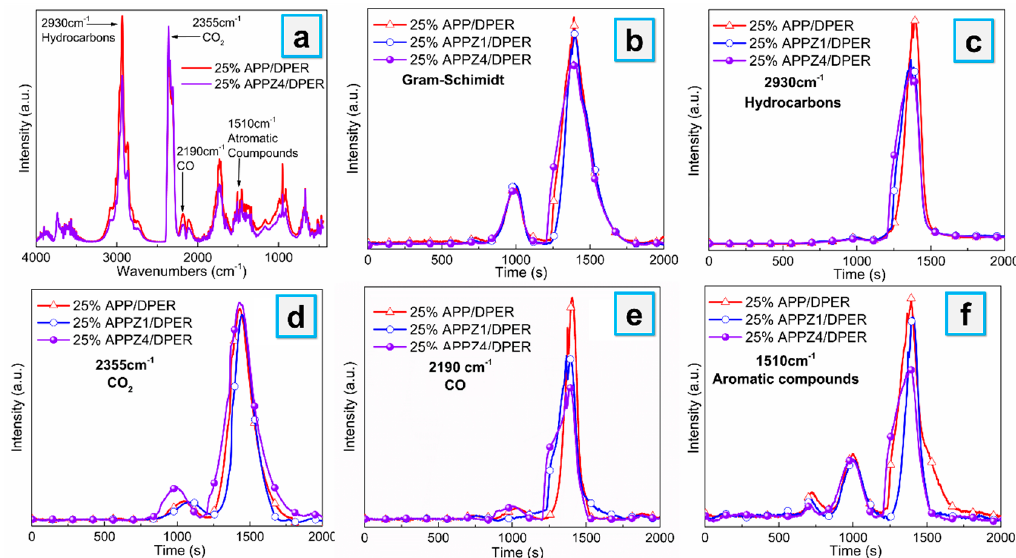
Figure 8. FTIR spectra of volatility at the maximum mass loss rate ( a ); absorbance of volatile products of EVA composites vs. time: ( b ) total pyrolysis products, ( c ) hydrocarbons, ( d ) CO 2 , ( e ) CO, and ( f ) aromatic compounds.